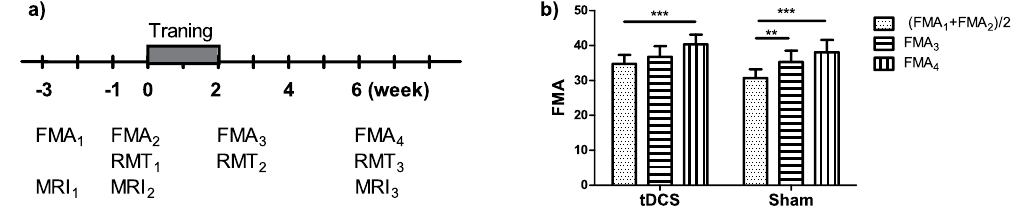
Figure 1. Study design and behavior outcome. ( a ) timeline of the training, clinical assessment of FMA score, resting motor threshold (RMT), and MRI. ( b ) Both tDCS and sham groups produce increase in the FMA after training. ** p < 0.01; *** p < 0.001. Error bar represents